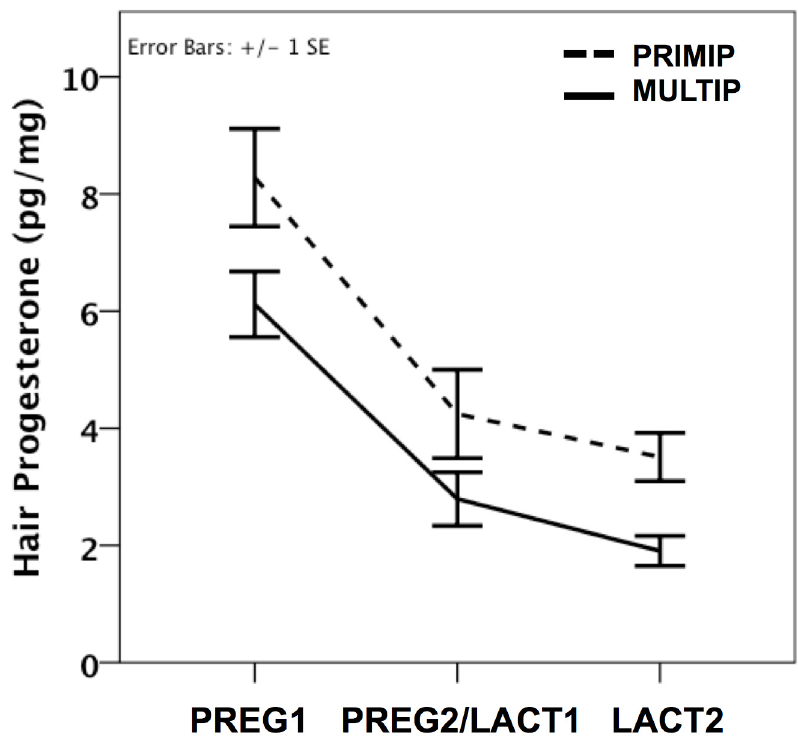
Fig 2. Parity differences in hair progesterone concentrations across pregnancy and lactation. PRIMP = primiparous, MULTIP = multiparous. PREG1 = mean ± SE gestational age 124.9 ± 8.7 days; PREG2/ LACT1 = mean ± SE gestational age 230.1 ± 8.7 days or mean ± SE postnatal age 60.1 ± 8.7 days; LACT2 = mean ± SE postnatal age 159.2 ± 8.8 days. * p < 0.05.